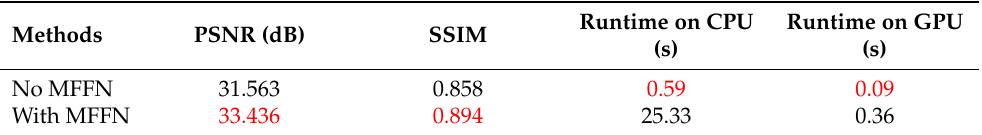
Table 4. Average PSNR, SSIM and Runtime of our method with MFFN and without MFFN. The highest score is highlighted in red.